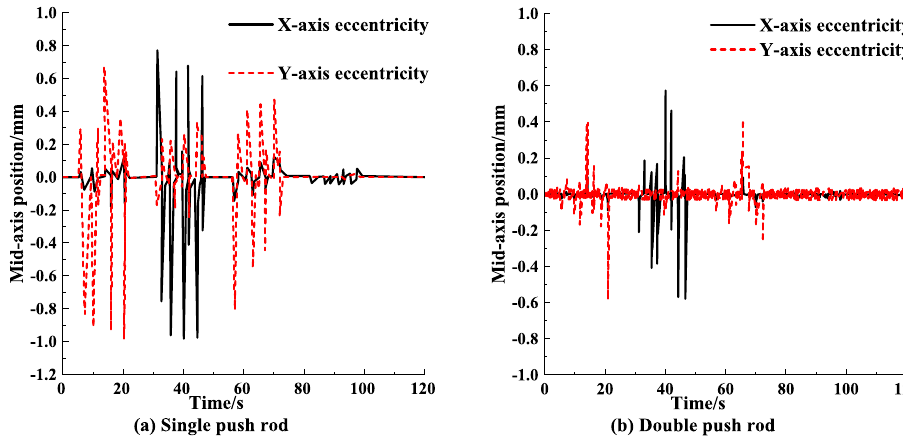
Figure 8. The displacement of the mid − axis of the single push rod support adjustment mechanism, double push rod − double spring support adjustment mechanism under well wall deposit obstacle.